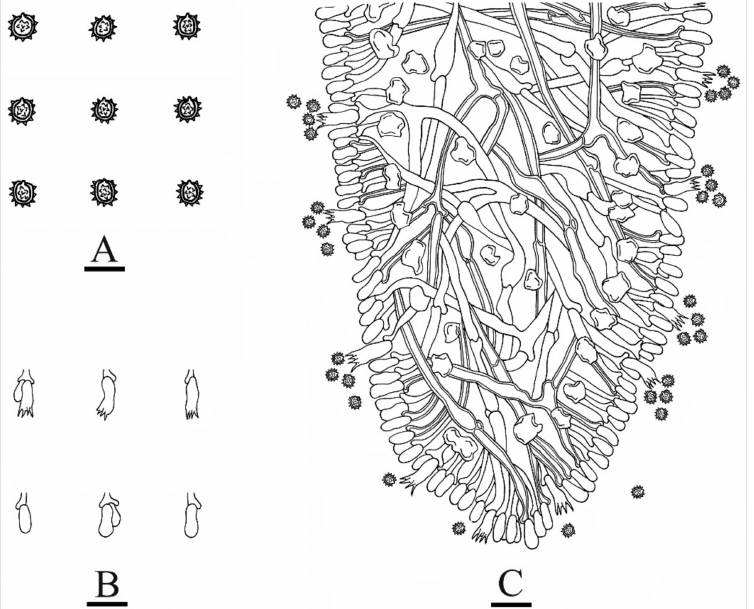
Figure 6. Microscopic structures of Trechispora odontioidea (holotype CLZhao 17890): basidiospores ( A ), basidia and basidioles ( B ), a cross section of basidiomata ( C ). Bars: ( A ) = 5 µ m, ( B , C ) = 10 µ